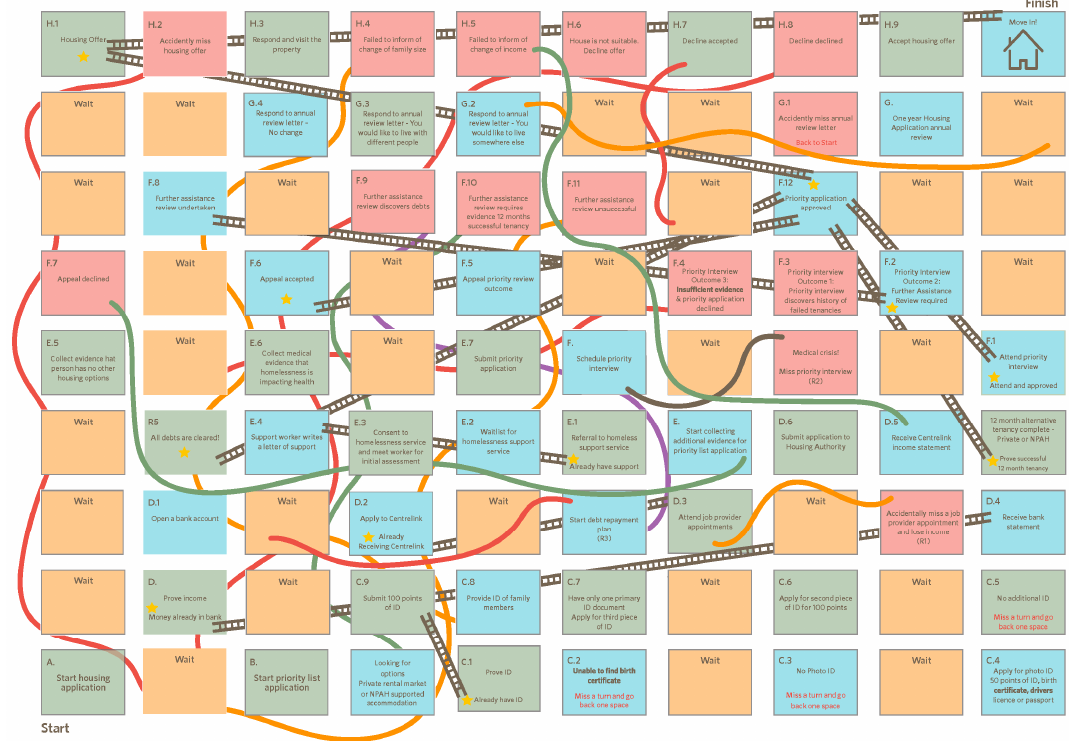
Figure 3. “Snakes and Ladders” to obtain a housing authority property in Western Australia. This diagram has been developed by Ruah’s Wongee Mia Action Research Group (L.W., M.P.,